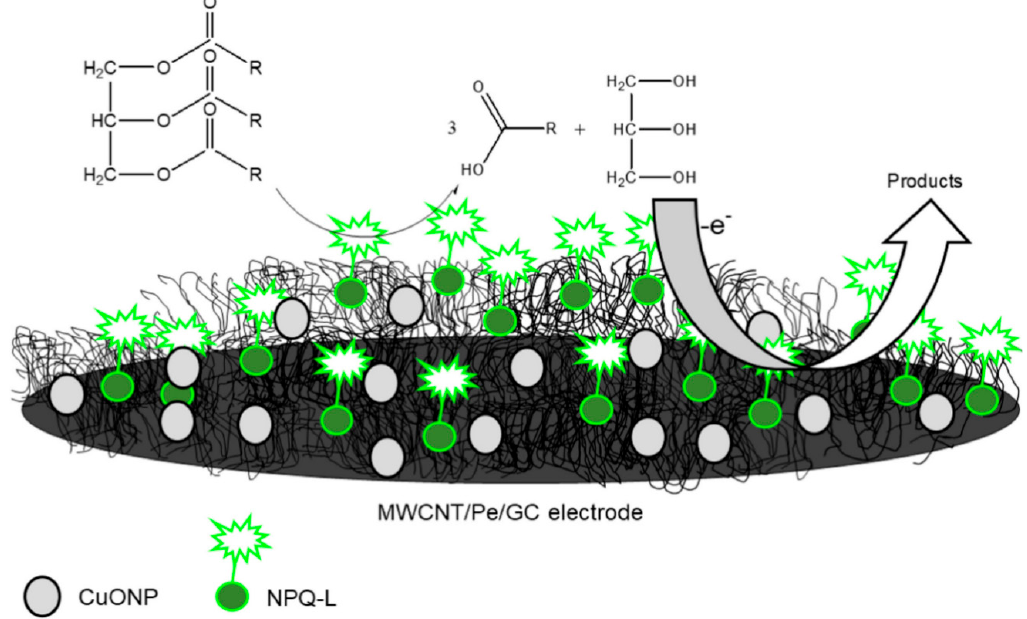
Figure 3. Graphic illustration of CNP － L/CuONP/MWCNT/Pe biosensor for determinations of triglycerides in serum specimens. Adapted from Ref. [66] with permission from Elsevier.